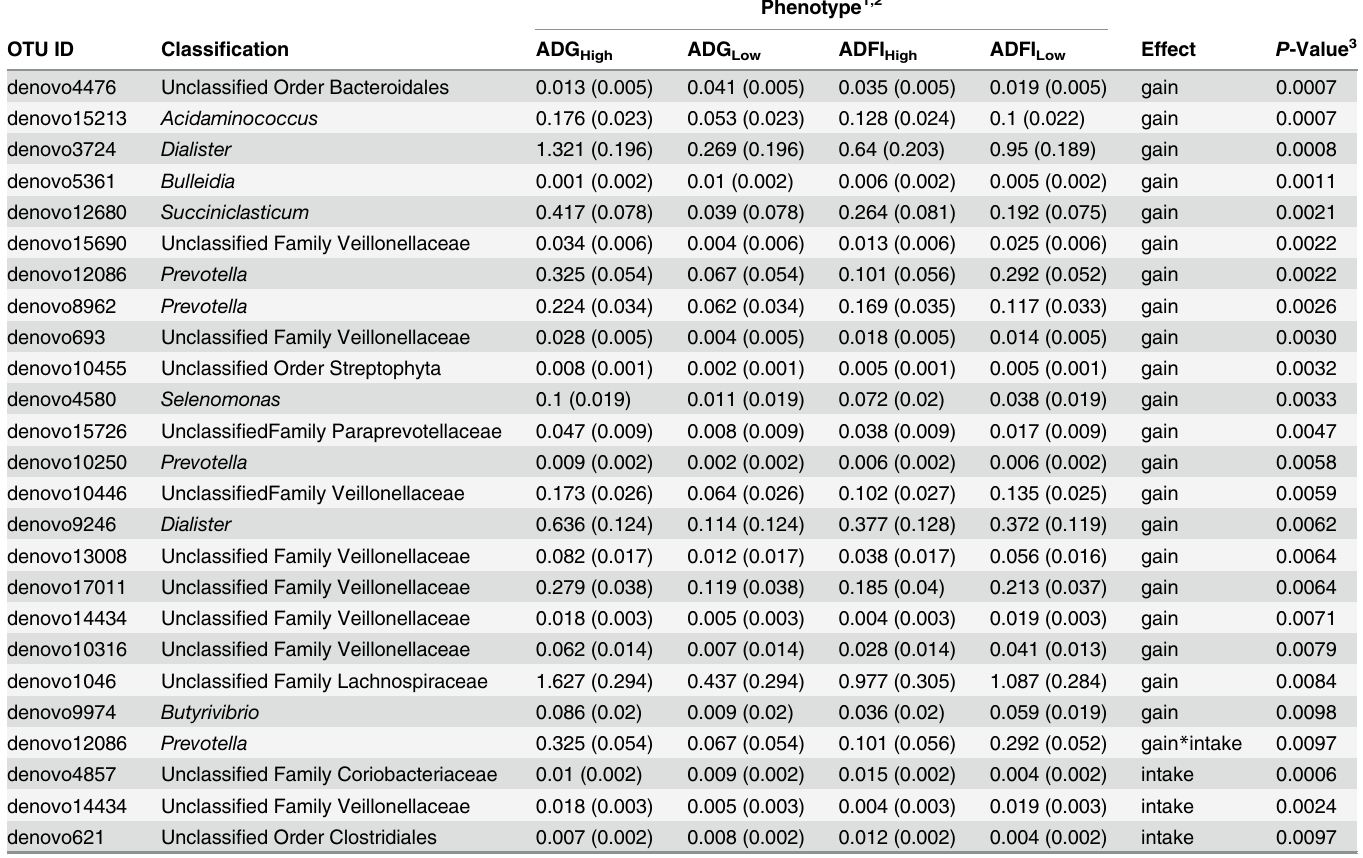
Table 5. Relative abundance of OTUs within ADG and